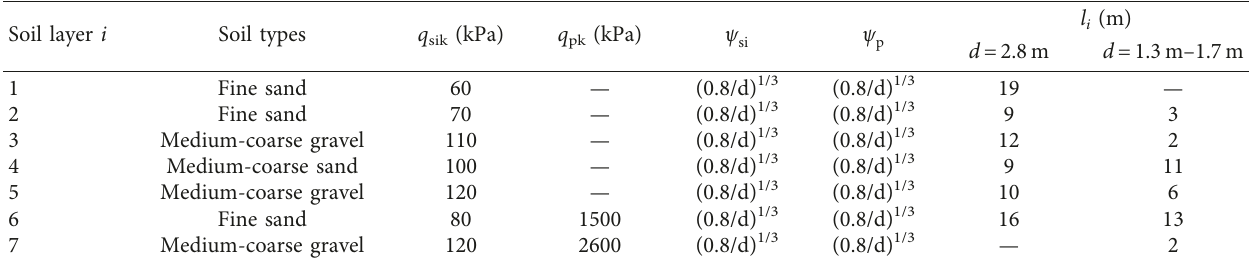
Table 4: Relevant parameters of the soil layers surrounding piles.